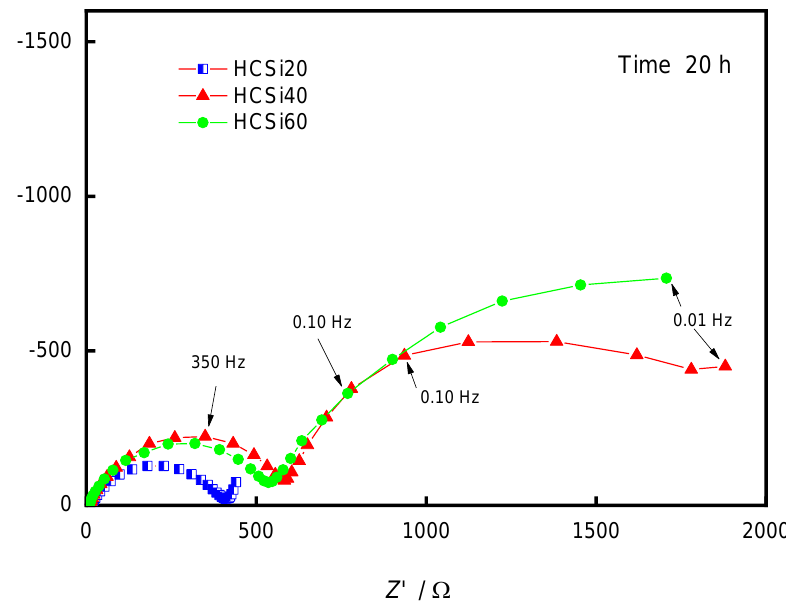
Figure 9. In situ GEIS impedance spectra compared for all three thicknesses after 20 h of lithiation in Nyquist plot.